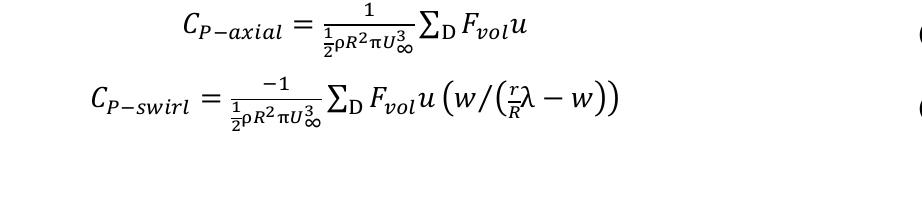
on Figure 8. The following conventions apply: Red lines are results using the standard BEM model with no far wake pressure loss term. The purple lines are for the BEM model with Burton’s [23] simplified pressure loss term, and the green lines are for the present BEM model with full inclusion of the far wake pressure